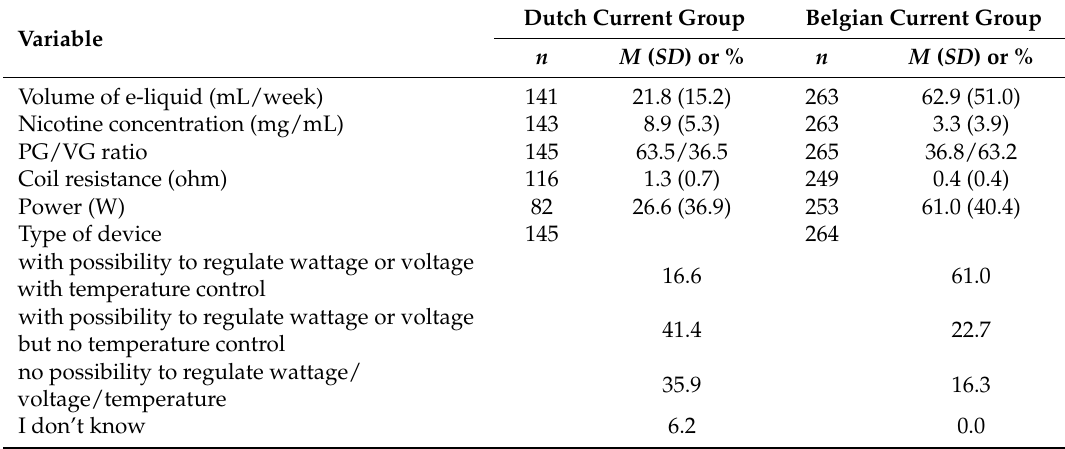
Table 2. Vaping parameters of the Dutch Current/Belgian Current